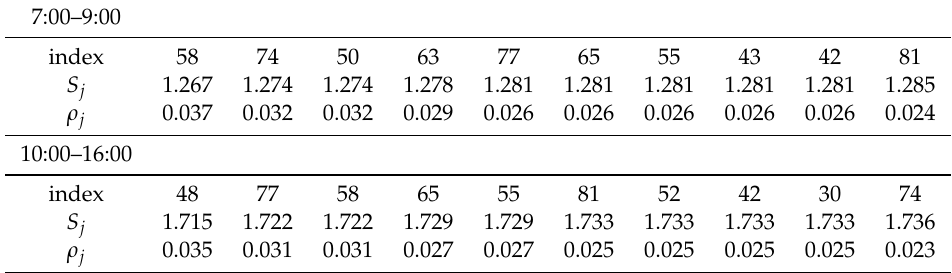
Table 1. Value of selection diversity and vulnerability with top 10 most vulnerable ambulance